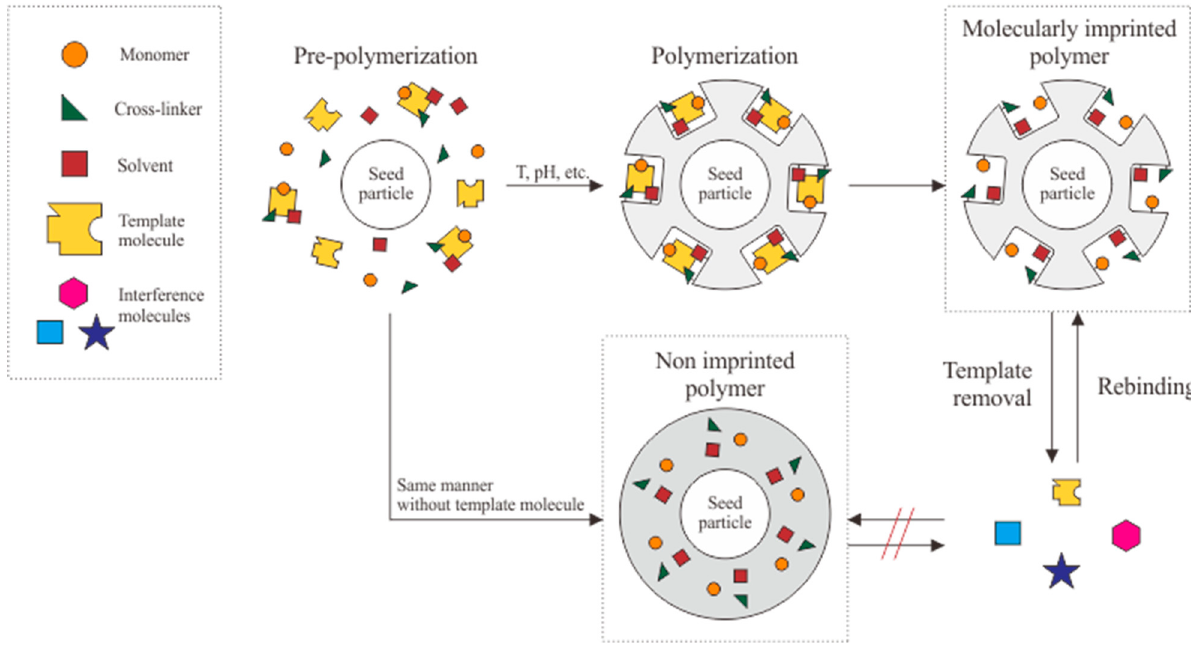
Figure 2. Schematic illustration of a basic molecularly imprinted polymer